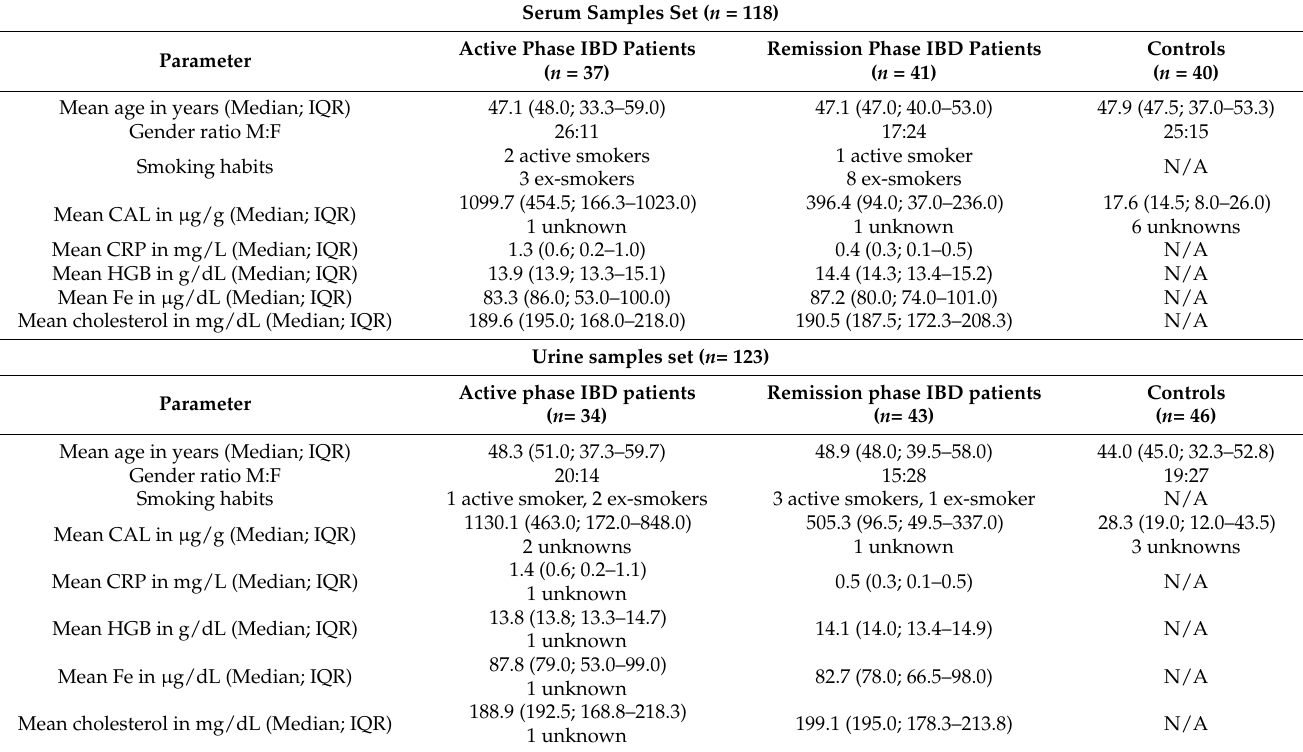
Table 1. Demographic data of IBD patients and healthy